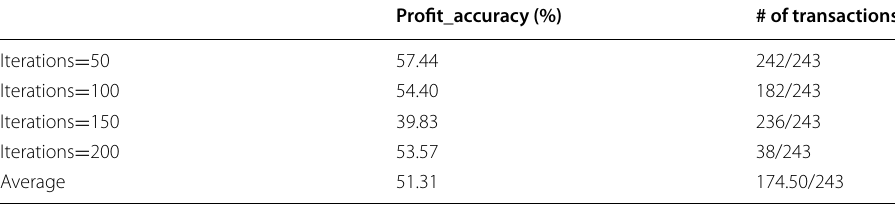
Profit_accuracy (%) # of transactions